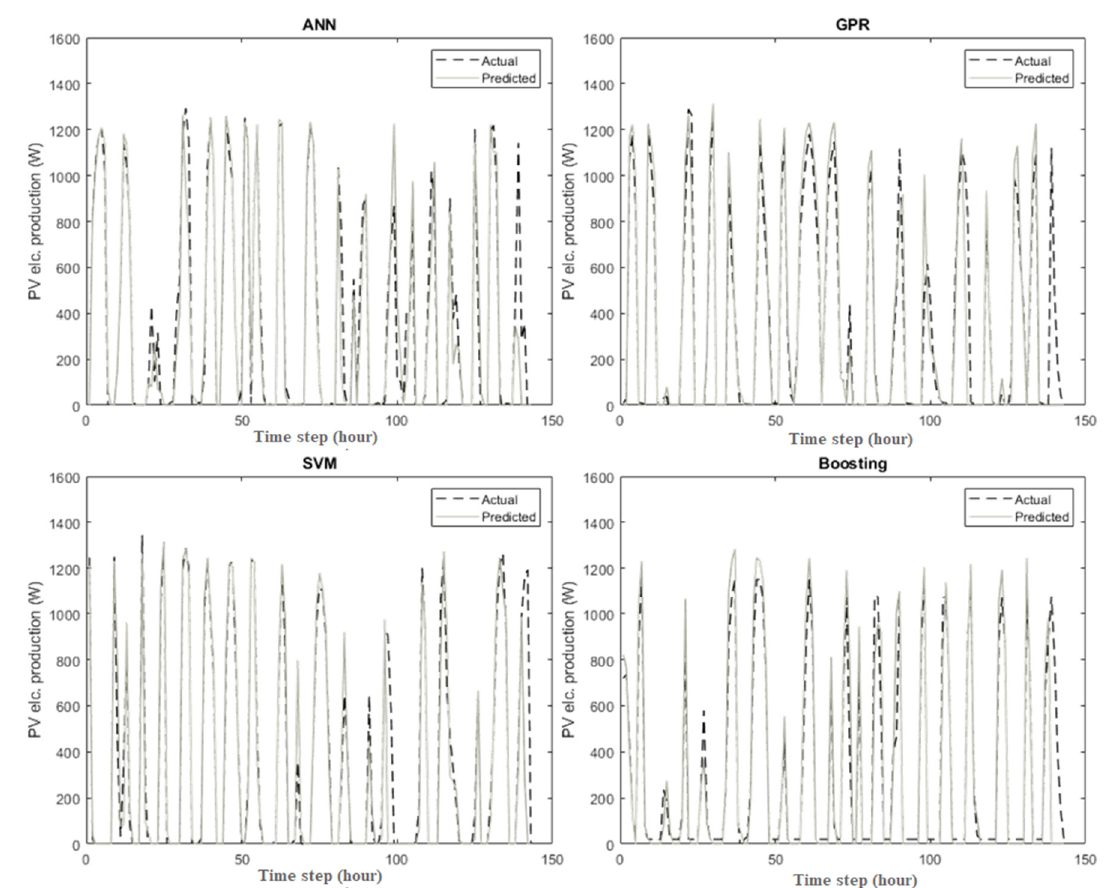
Figure 9. Measured and predicted PV module electrical production of mid-August to mid-September (validation set).